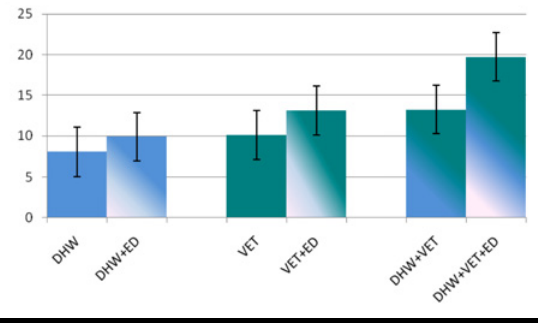
Effect of educational programs on improvement of mange-like